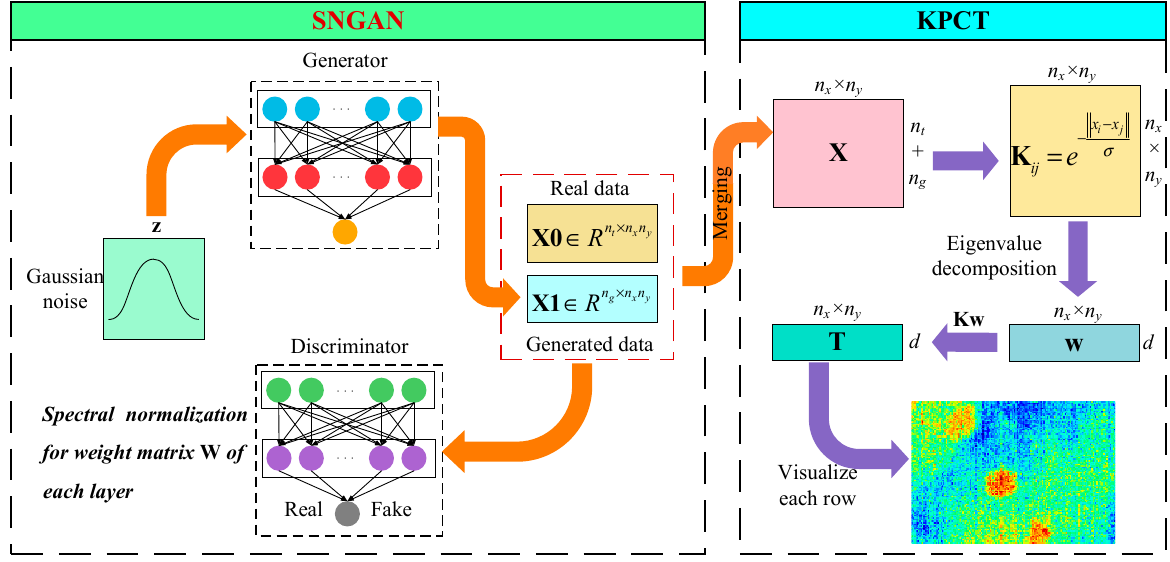
Figure 1. The GKPCT modeling and analysis framework.